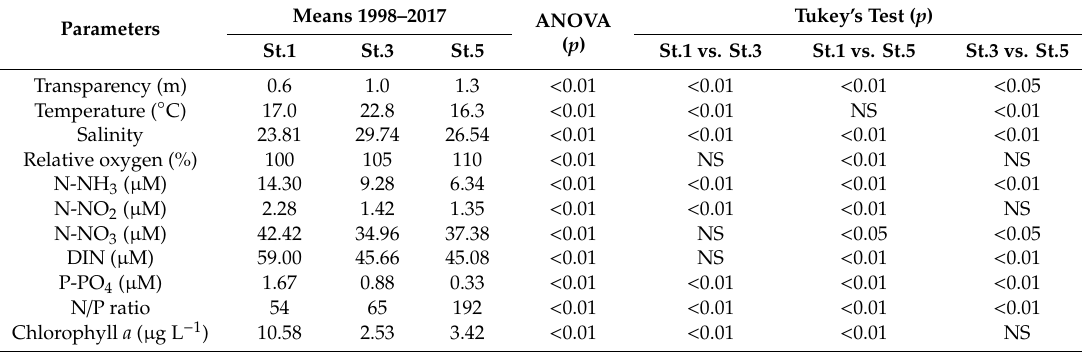
Table 1. Hydrochemical parameters in the three sampling stations: comparison of twenty-year averages (p = probability level; NS = not